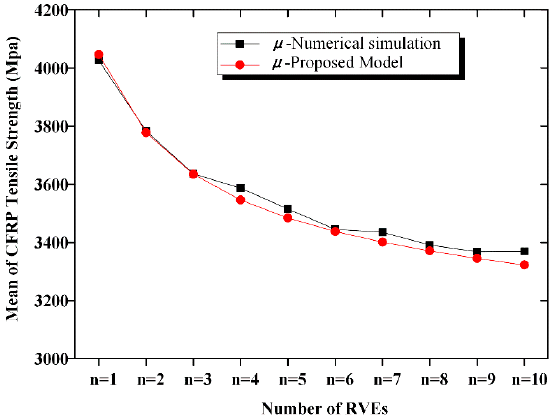
Figure 14. Comparison of the mean strength of the n-element parallel system.